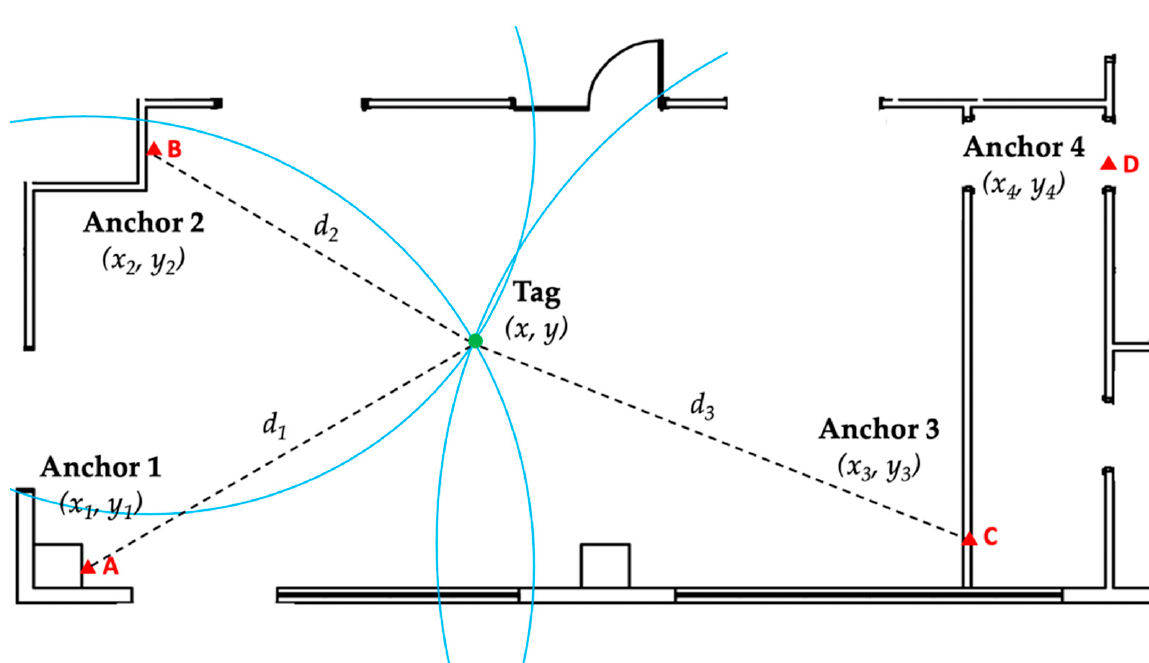
Figure 2. Illustration of trilateration technique.